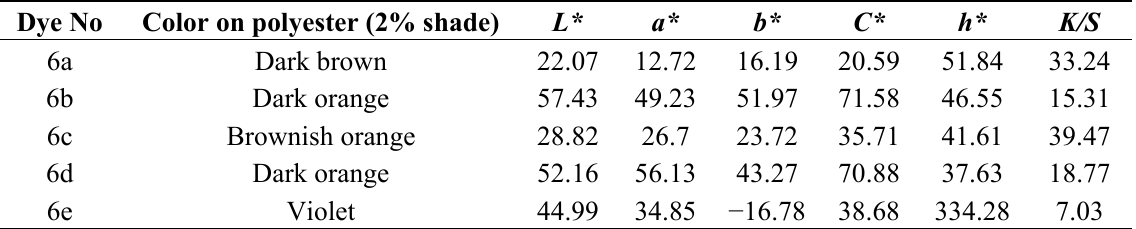
Table 2. Shade and optical measurements of the azo disperse dyes on the polyester fabrics using microwave dyeing method.